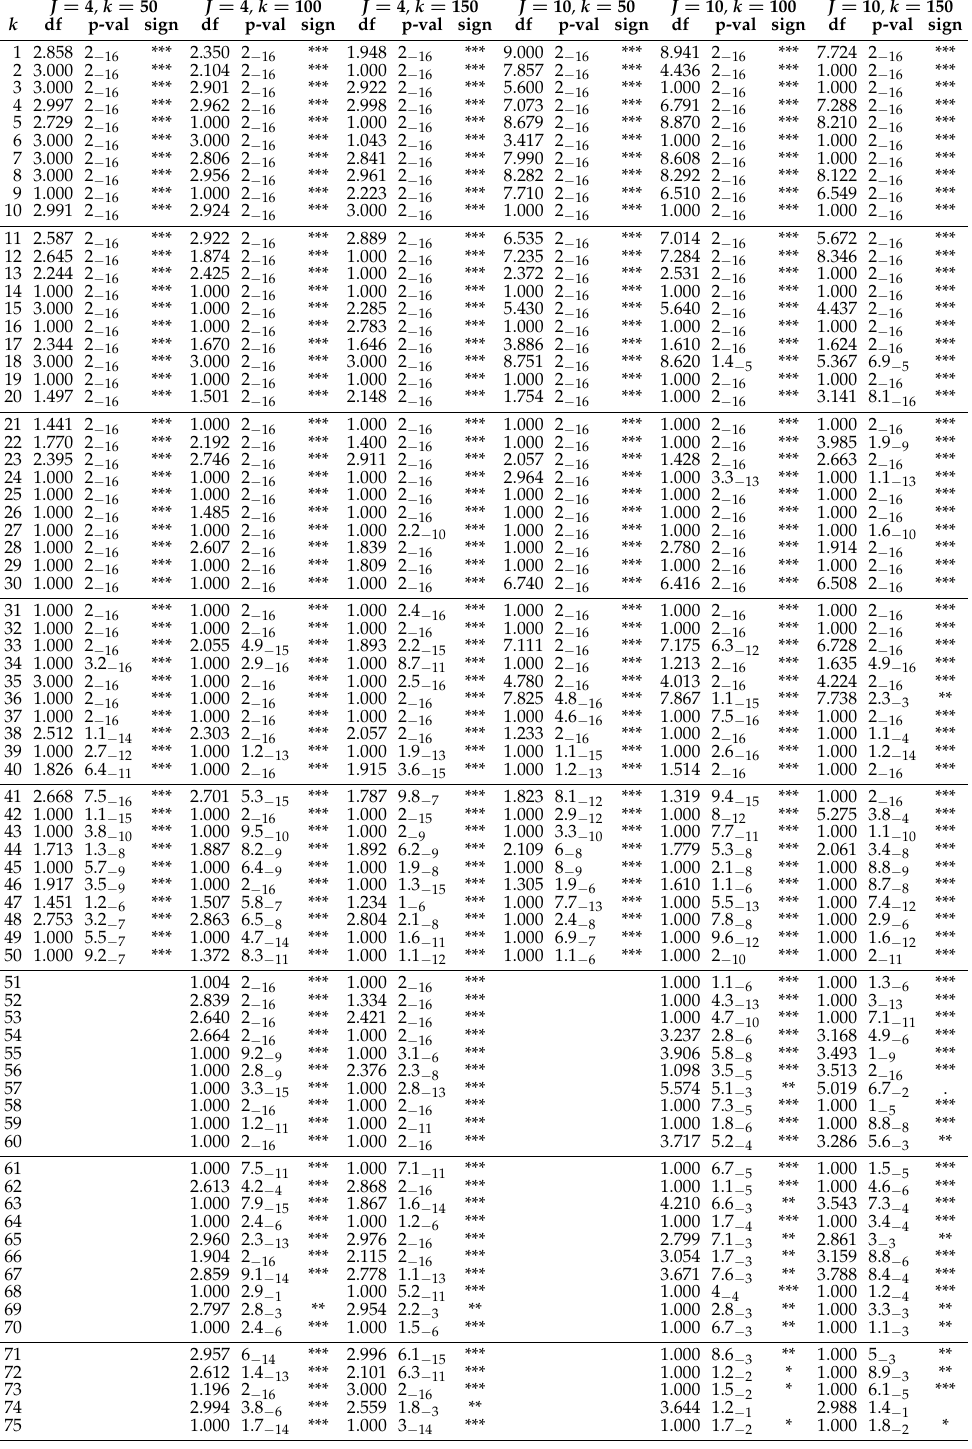
Table A16. Effective degrees of freedom, p-values and significance codes per dimension of GAMs of BEL built up of thin plate regression splines with gaussian random component and identity link function under 150–443 for spline function numbers J 50,100,150 . The confidence levels corresponding to the indicated significance codes are k ∈ { } *** = 0.001, ** = 0.01, * = 0.05, = 0.1, =